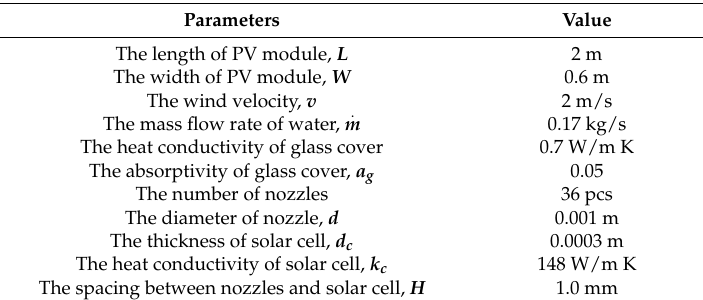
Table 3. The design parameters of the PVT